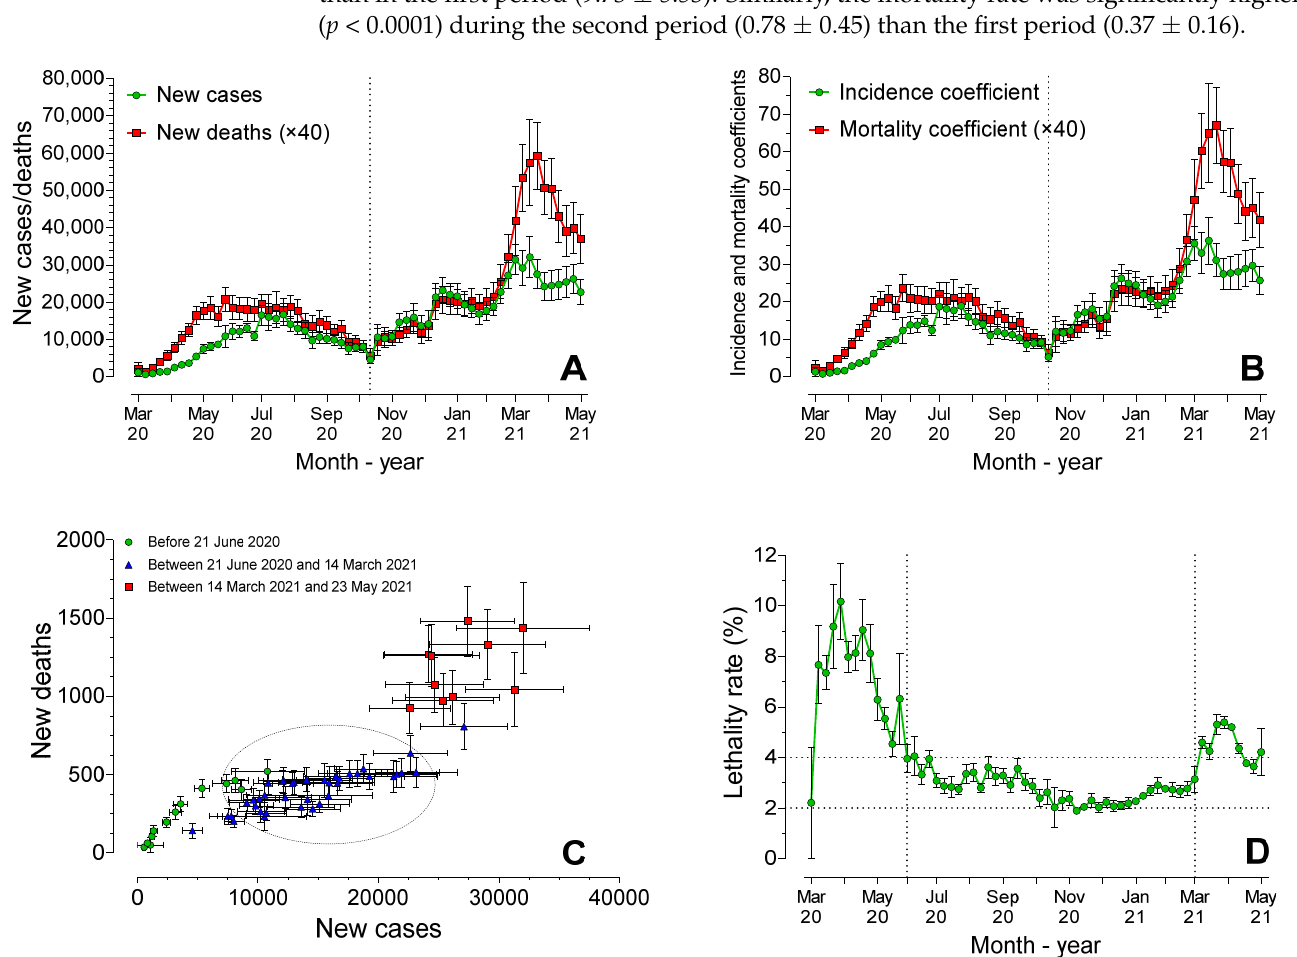
Figure 1. Weekly mean (± standard error) of the number of new cases and new deaths ( A ), coefficient of incidence and coefficient of mortality ( B ), correlation between number of new cases and new deaths ( C ) and lethality rate ( D ), throughout this period.